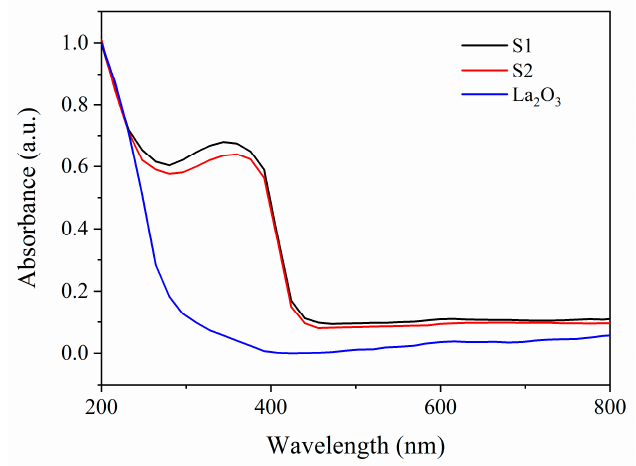
ff use reflectance spectra of La